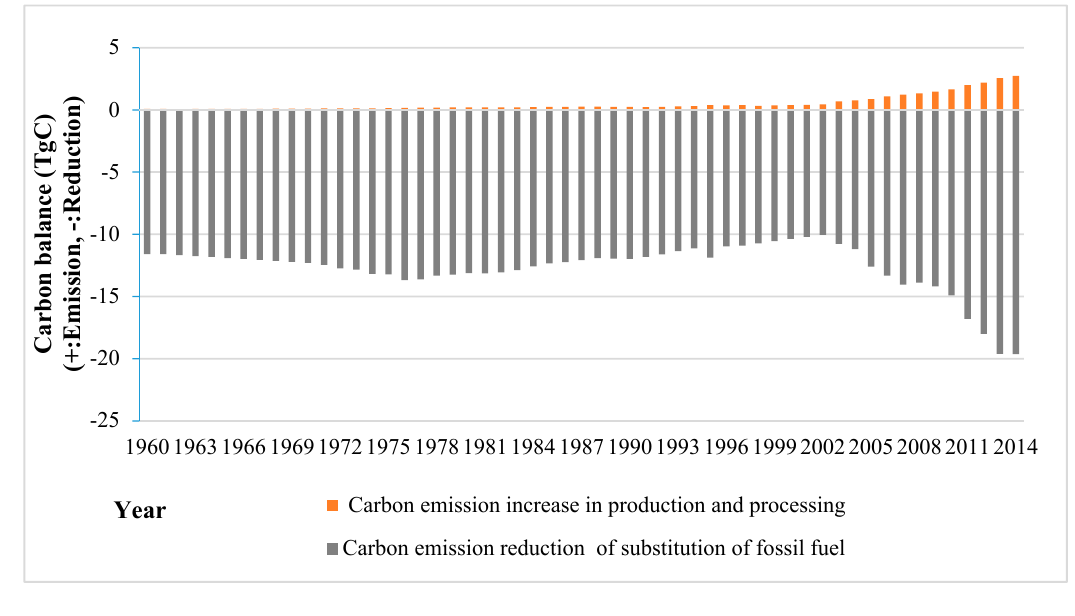
Figure 4. Carbon balance between carbon substitution and carbon emission of China’s HWP from 1960 to 2014. Int. J. Environ. Res. Public Health 2016 , 13 , 1132